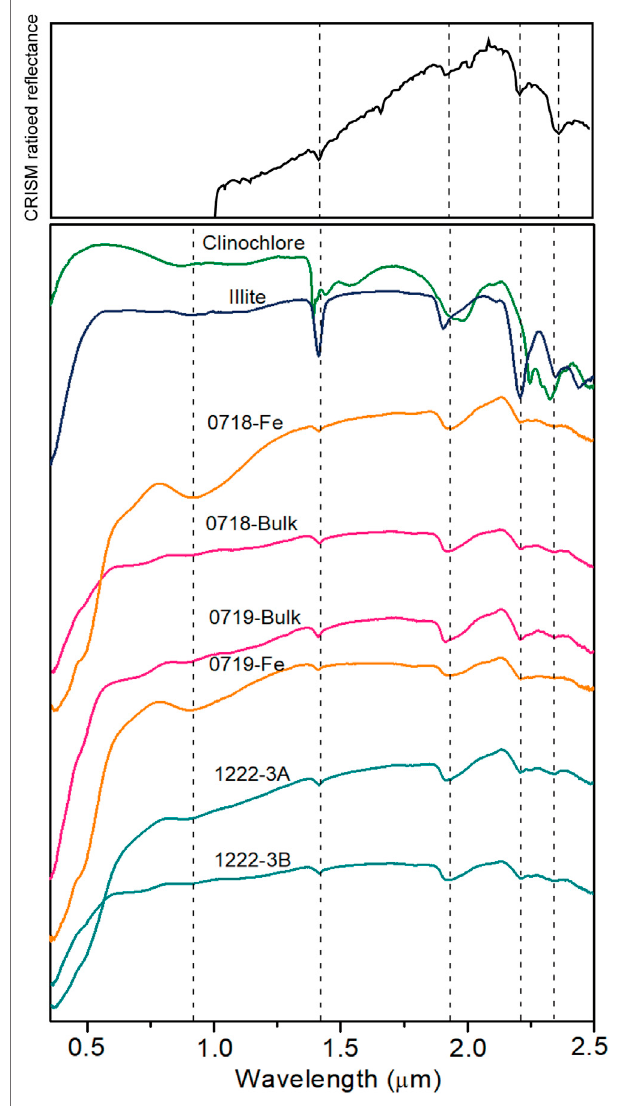
FIGURE8| NIRspectraoftheQaidamlacustrine- fl uvialdepositsandthe CRISM spectrum (Ehlmann et al., 2009) from the Nili Fossae region